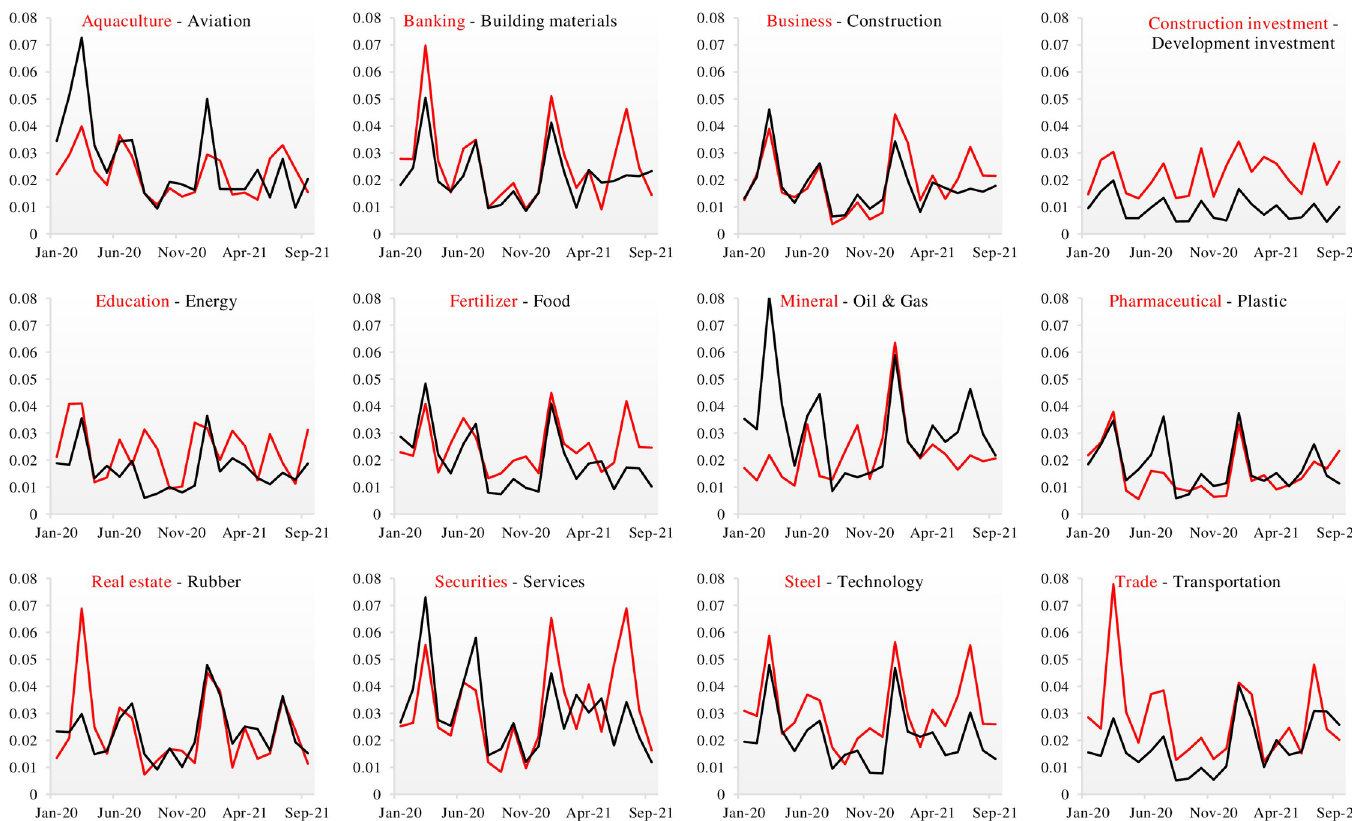
Fig 1. Monthly market risk for 24 sectors in Vietnam during Covid-19 pandemic. This figure presents monthly market risk for 24 Vietnamese sectors during Covid-19 pandemic in 2020 and 2021. 12 pairs of sectors are graphically illustrated. The red line presents the monthly market risks for a Vietnamese sector which appears first in the pair. The black line presents the monthly market risks for a sector which appears second in the